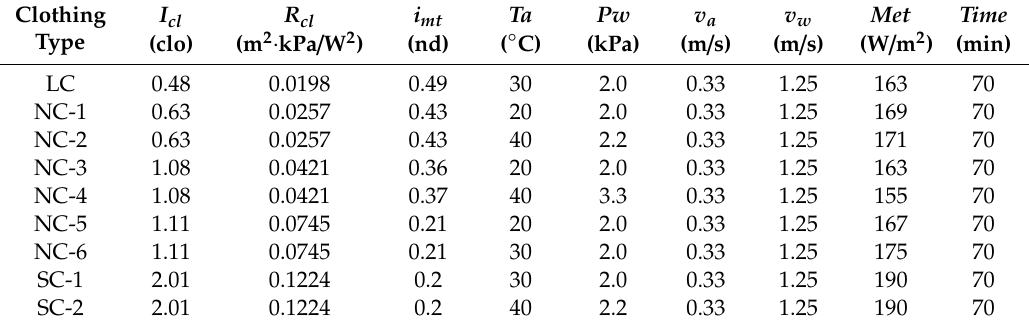
Table 5. The input parameters of the PHS model for predicted rectal temperature, water loss, and maximum exposure